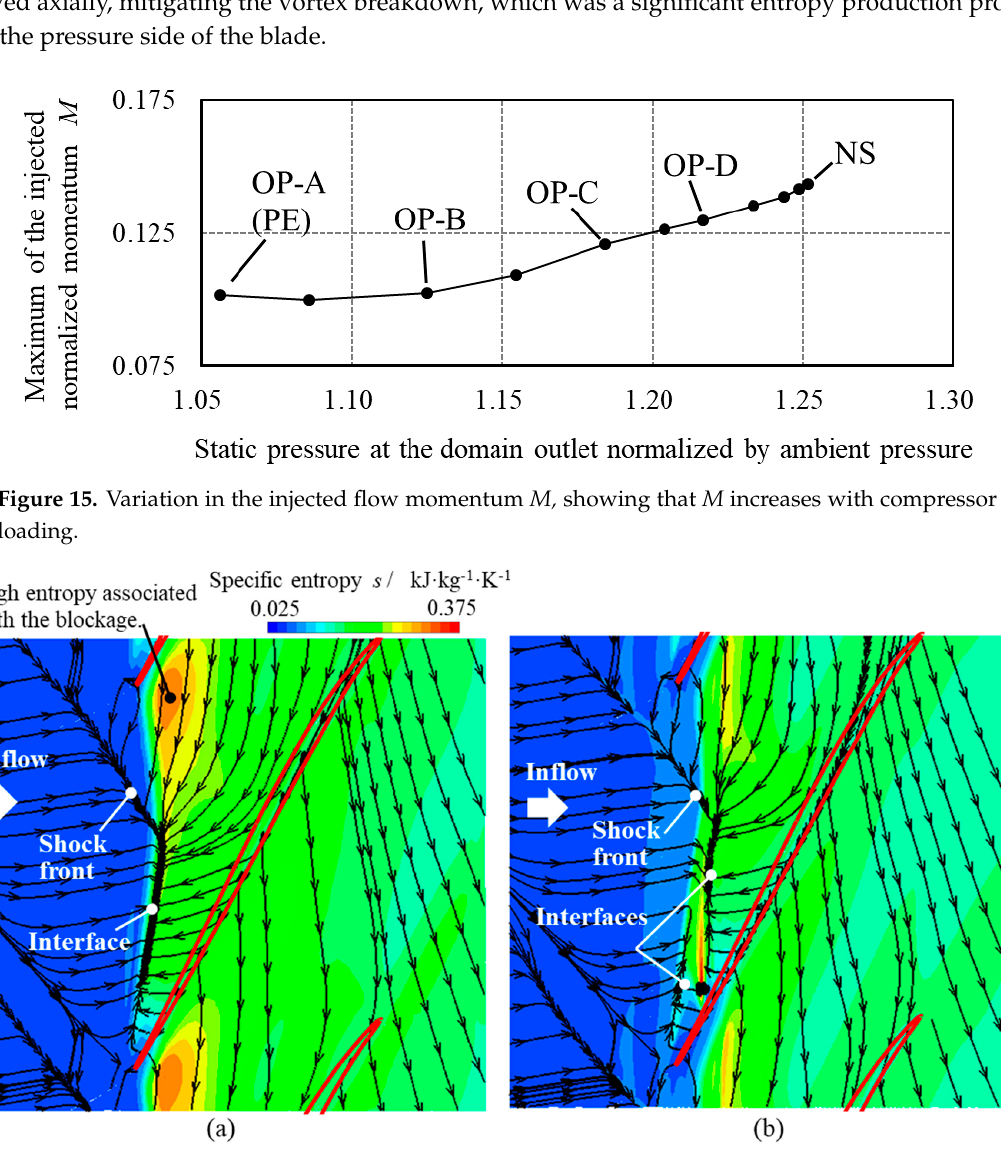
Figure 14. Distribution of the injected momentum in the axial direction showing an intense injection near the blade SS (OP-D).